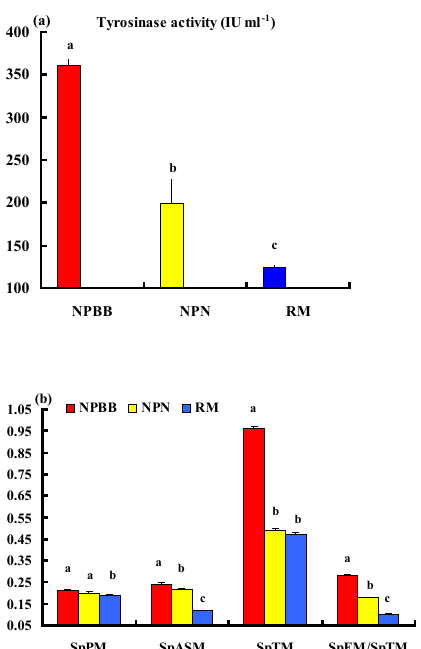
Figure 4. Plasma tyrosinase activity (a) and concentrations of phaeomelanin (SpPM), alkali-soluble melanin (SpASM) and total melanin (SpTM) in the plasma as well as the ratio of plasma eume- lanin:total melanin (SpEM:SpTM) for the Nanping black-boned, Nanping normal and Romney Marsh (RM) sheep (b) . Values pre- sented are means and values shown with different letters (a–c) differ significantly ( P <